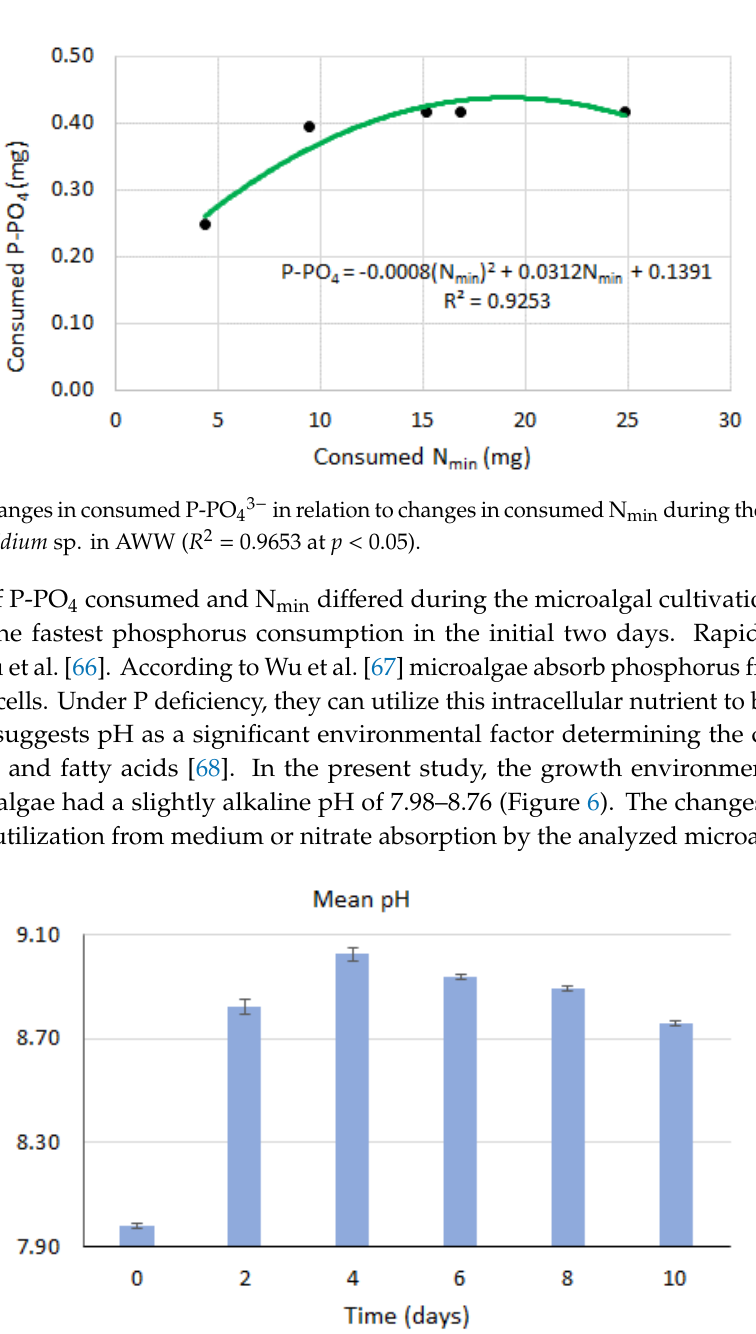
Figure 6. Reaction pH of AWW with algae (mean ± SD; ANOVA: F = 3993, p < 0.05).